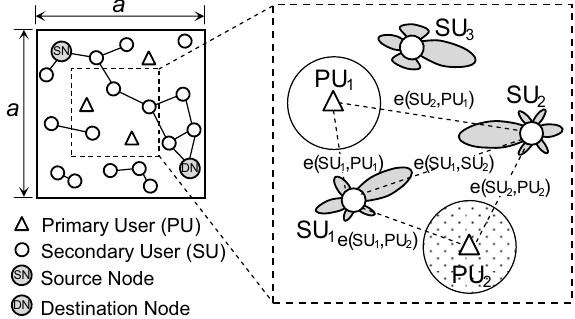
Figure 4. The network model of CRAHNs where SUs employ directional antennas and PUs use omnidirectional